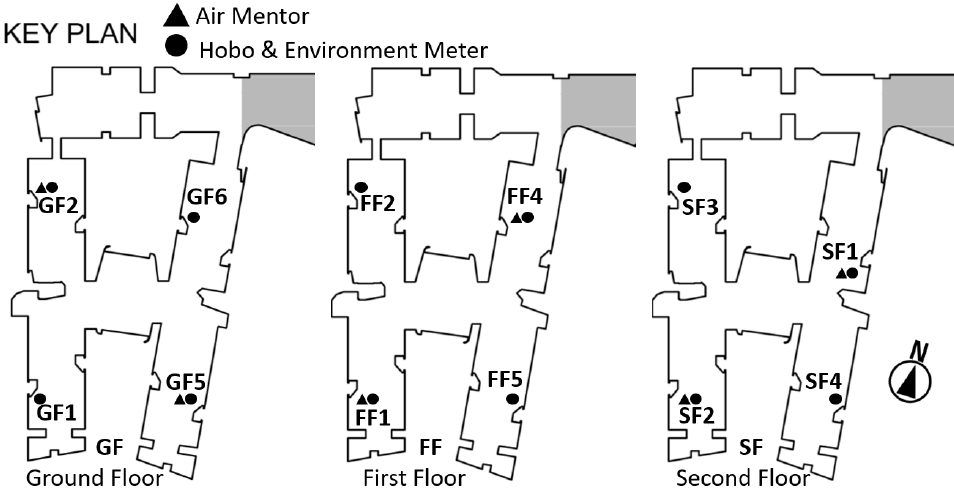
Figure 3. Monitoring device locations in the floor plan.